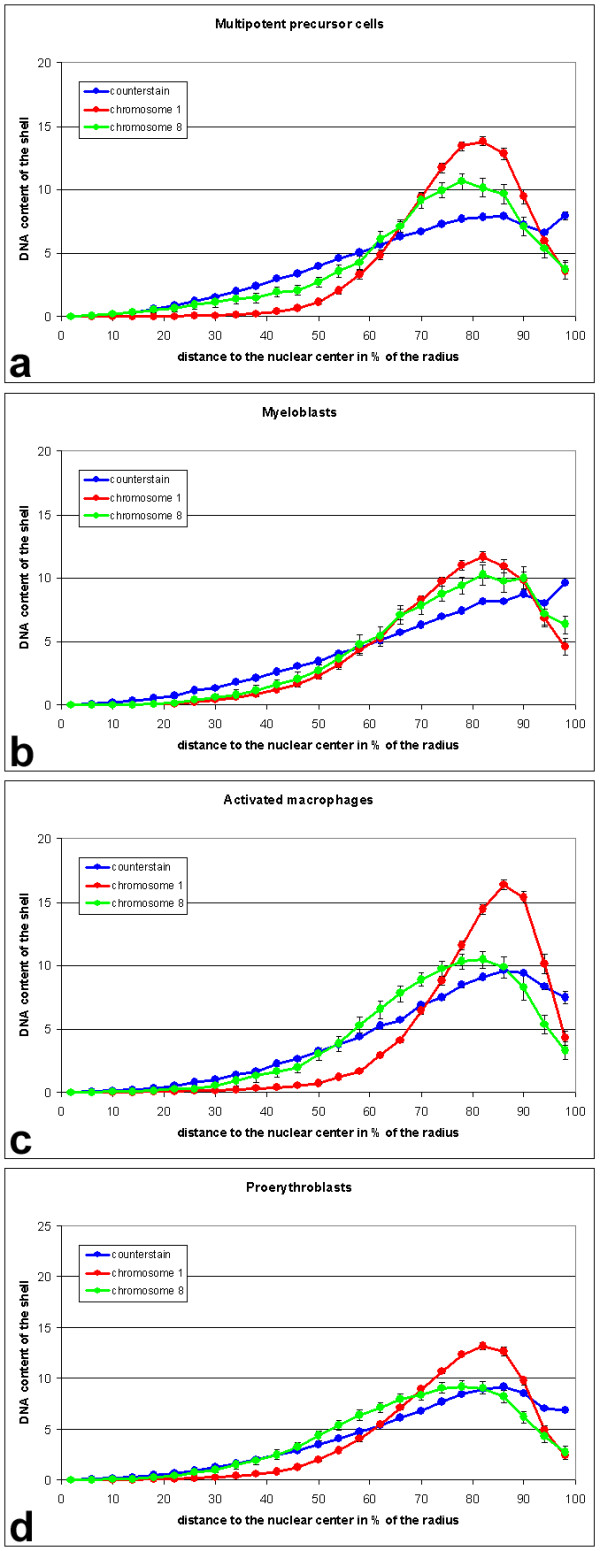
Radial distribution of chromosomes 1 (red) and 8 (green) in nuclei of (a) multipotent precursor cells (n = 37), (b) myeloblasts (n = 27), (c) activated macrophages (n = 23) and (d) proerythroblasts (n = 40). Unlike in the median distribution used for determination of significance levels, in the graphs shown here all voxels of a segmented signal are represented. Chromosome 8 has only about one sixth of the size of chromosome 1. Accordingly, its interphase territories are much smaller, leading to a smaller sample of voxels and thus accounting for less smooth curves than for chromosome 1 territories, e.g. in myeloblasts. All curves for each chromosome are shown in one graph in a supplemental figure in additional file 1.